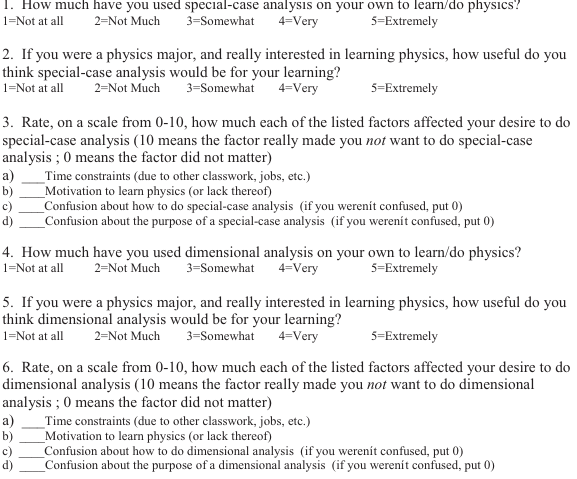
FIG. 2. End-of-year survey questions regarding the students’ self-reported use of each evaluation strategy.